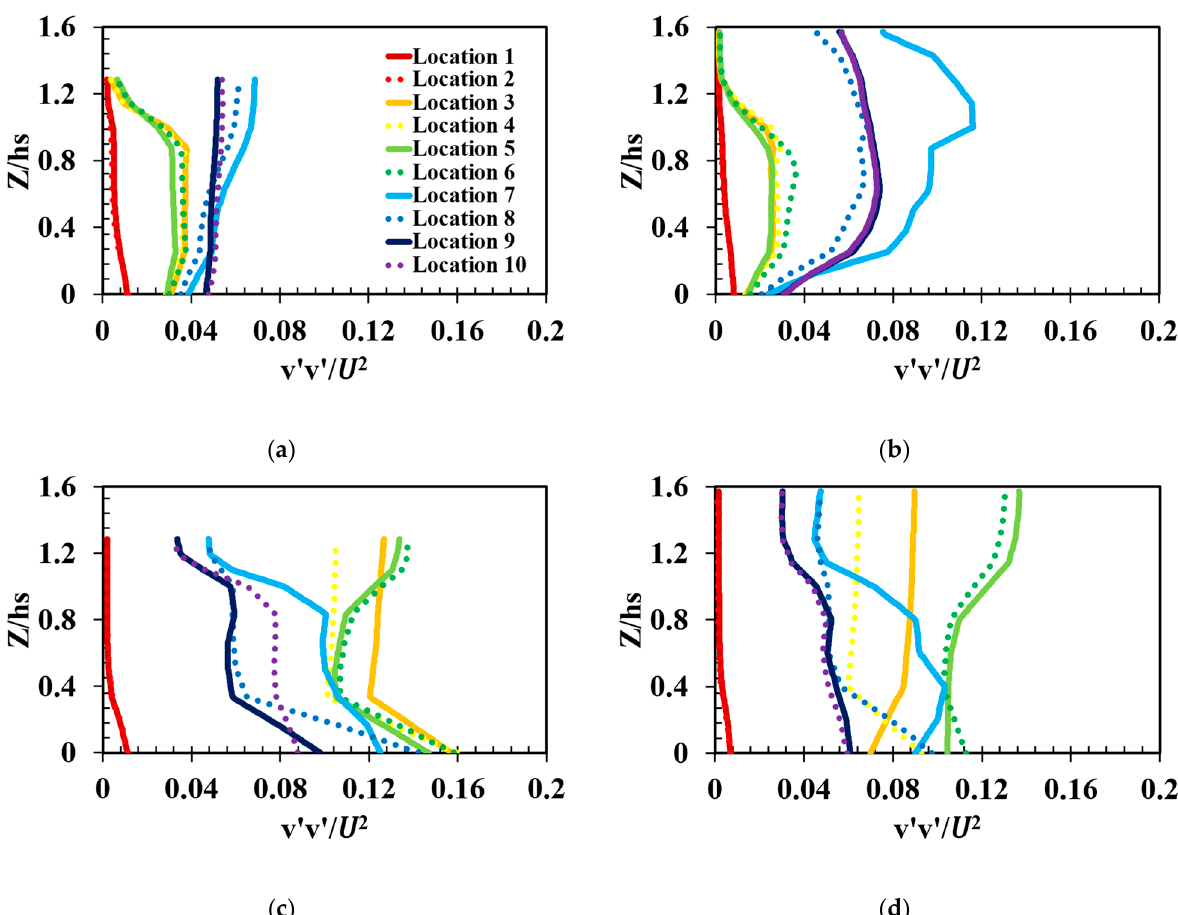
Figure 9. ( a – d ) The vertical profiles of normal stresses ( v’v’ ) at specified locations: ( a ) case 1; ( b ) case 2; ( c ) case 3; ( d ) case 4.